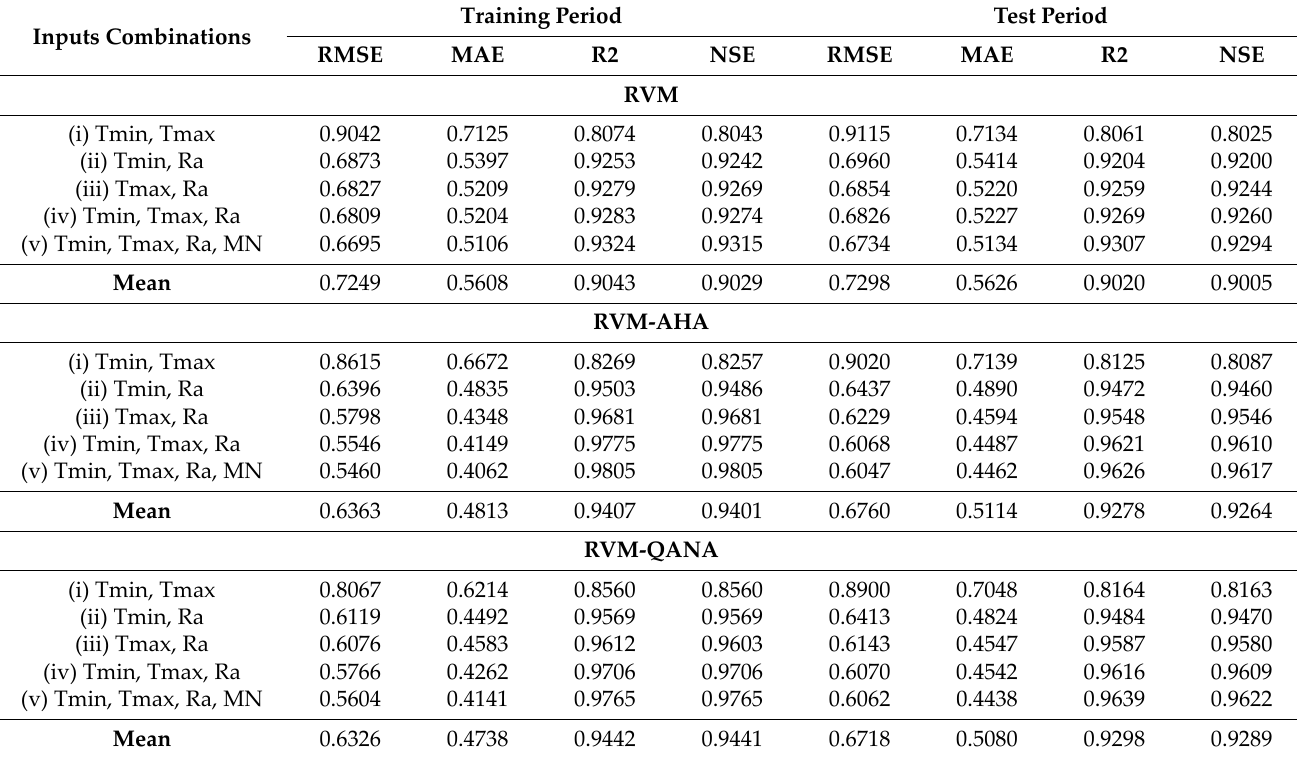
Table 4. The results of the RVM‑based models for Faisalabad Station using the best training‑test partition (75–25%